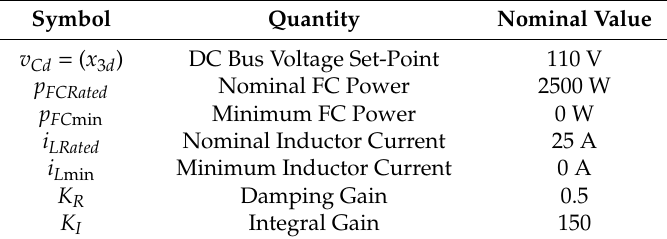
Table A2. Controller